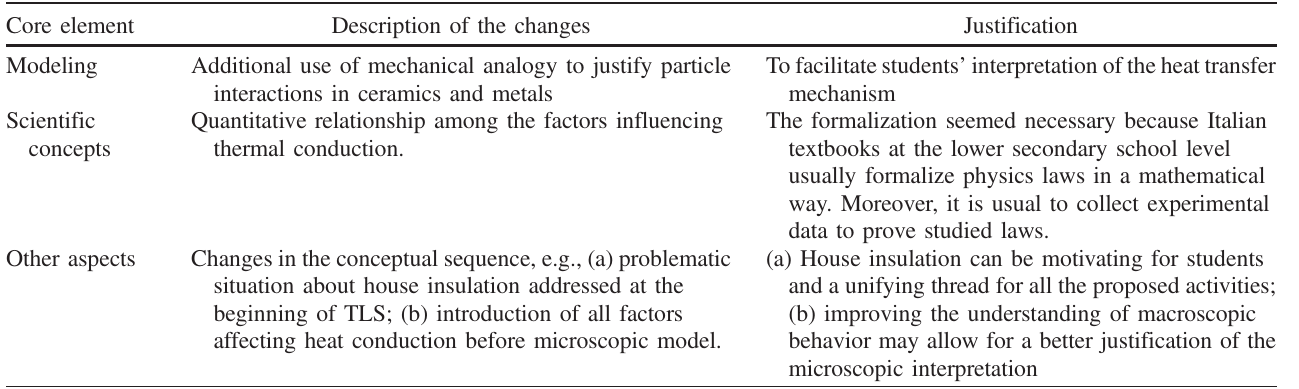
TABLE IV. Changes to the core elements of the transferred TLS on thermal conductivity.